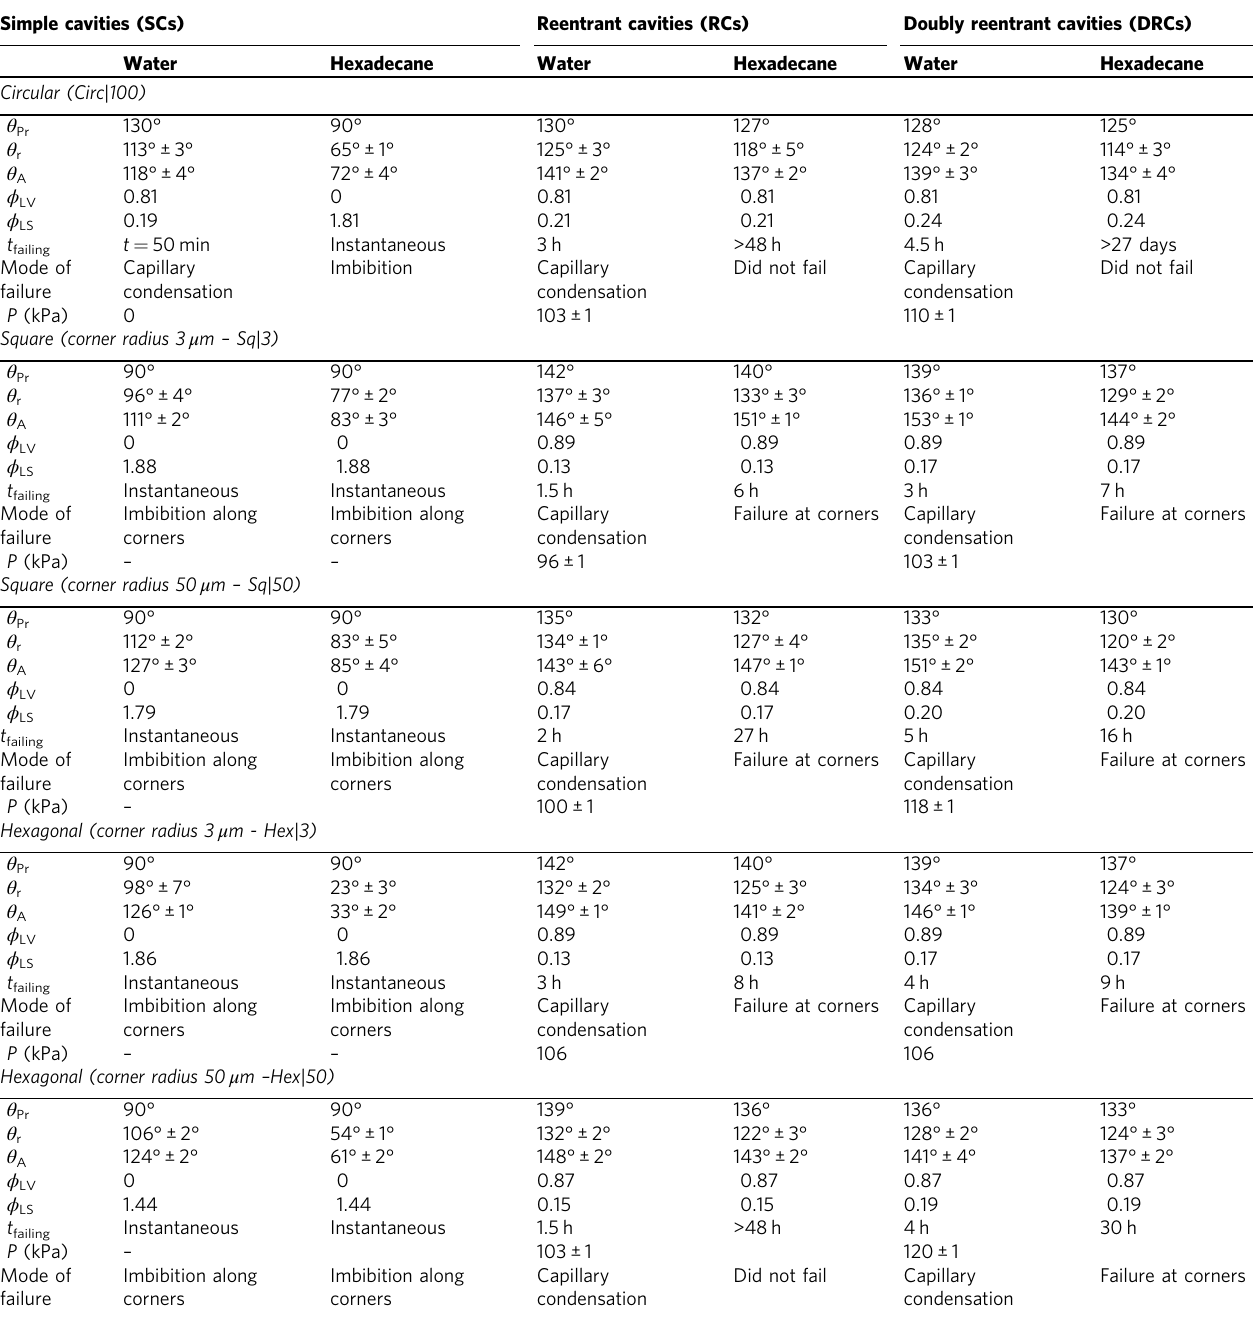
Table 1 A summary of all the experimental data presented in this work Simple cavities (SCs) Reentrant cavities (RCs) Doubly reentrant cavities